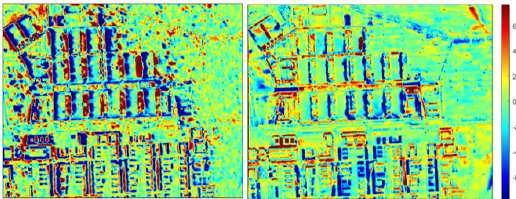
Figure 4. Height residual maps of industrial area: TanDEM-X DEM (Left) and Cartosat-1 DEM (Right)